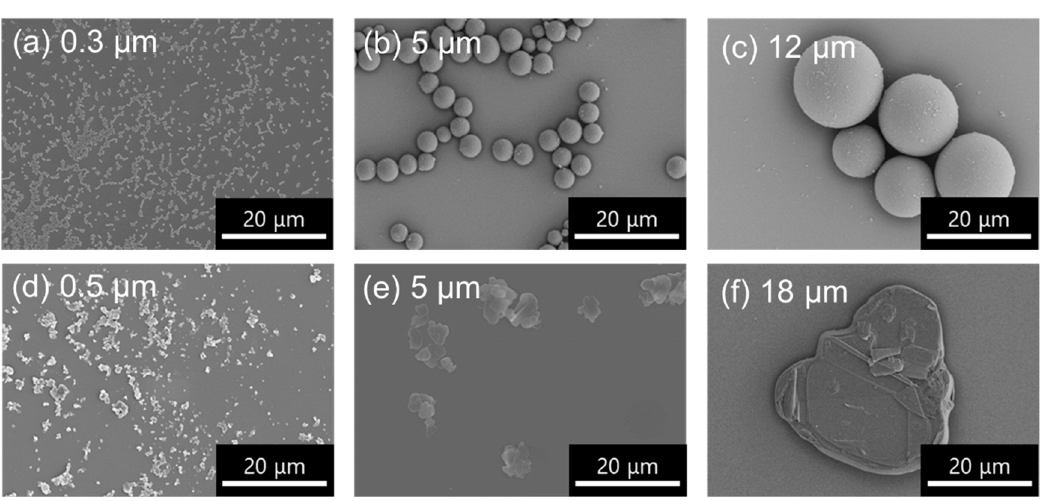
Figure 1. SEM images of the starting materials used for hexagonal boron nitride (hBN) / poly (methylmethacrylate) (PMMA) composite formation. PMMA particles with di ff erent sizes of ( a ) 0.3, ( b ) 5, and ( c ) 12 µ m, and hBN sheets with di ff erent sizes of ( d ) 0.5, ( e ) 5, and ( f ) 18 µ m were used. Figure 2. SEM images of the hBN/PMMA (PMMA core) composite particles obtained after electrostatic nano-assembly method using various sizes combination of ( a ) 0.5-µm hBN on 5-µm PMMA, ( b ) 0.5-µm hBN on 12-µm PMMA, and ( c ) 5-µm hBN on 12-µm PMMA.